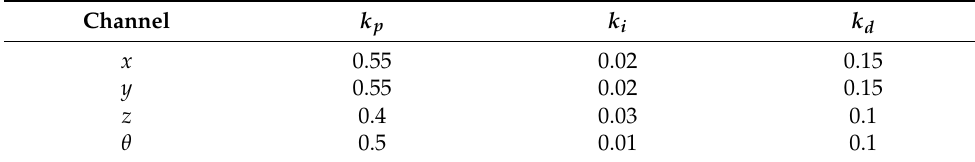
Table 1. PID gains for speed control of roll ( x ), pitch ( y ), yaw ( θ ), and thrust ( z ). Channel